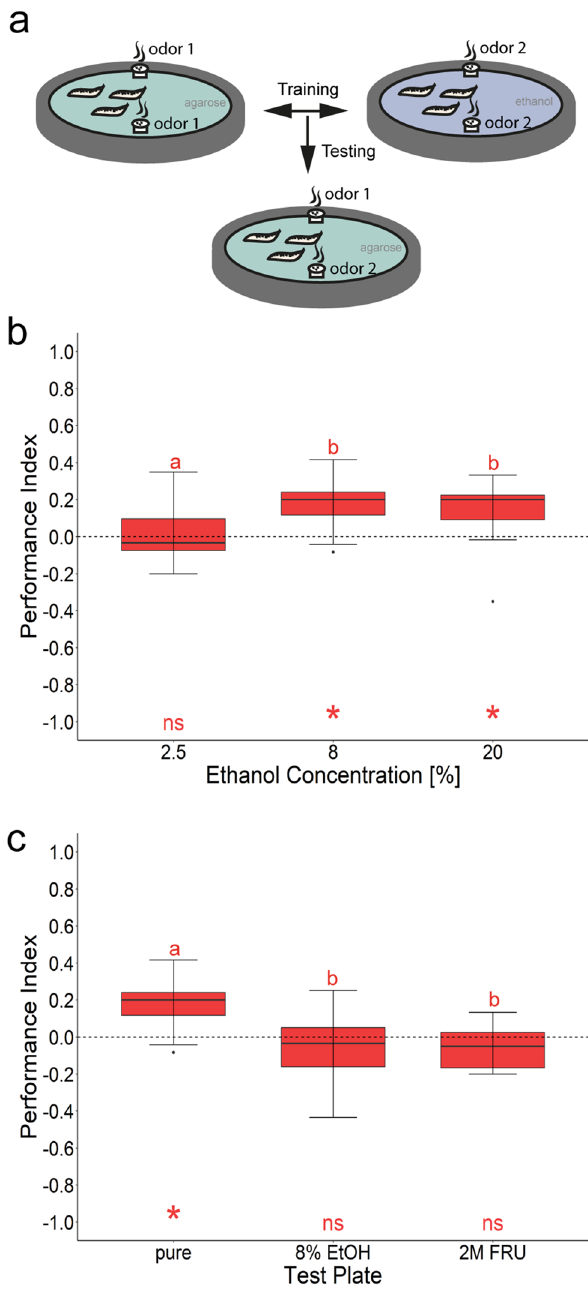
Figure 5. Larval olfactory learning reinforced by three different ethanol concentrations. ( a ) Scheme of the experimental procedure. Canton-S were trained three times with two odorants (AM and BA) and either 2.5%, 8%, or 20% ethanol as reinforcer. Olfactory memory is quantified by the performance index (PI). ( b ) Larvae trained with 8% and 20% ethanol concentration show a significant appetitive memory ( PI 8%Ethanol = 0.20, ci = 0.11–0.26, PI 20%Ethanol = 0.20, ci = 0.05–0.24, one-sample t test, p 8% < 0.001, p 20% < 0.005). When 2.5% ethanol was used as a teaching signal no memory was detectable ( PI 2.5%Ethanol = 0.83, ci = − 0.07 to 0.08, one-sample t test, p 2.5% < 0.828). Accordingly, larvae trained with 8% and 20% ethanol behaved differently from larvae trained with 2.5% ethanol (Dunn’s Multiple Comparison test, p < 0.001 and p < 0.003, respectively). ( c ) Larvae trained with 8% ethanol concentration as teaching signal and tested on control agarose showed a significant appetitive memory ( PI = 0.20 , ci = 0.11–0.26, one-sample t test, p < 0.001); if tested in the presence of the teaching signal of 8% ethanol or 2 M fructose (2 M FRU), appetitive associative memory is not expressed ( PI 8%Ethanol = − 0.03, ci = − 0.17 to 0.05, PI 2MFru = − 0.05, ci = − 0.11 to 0.01) as it is not significantly different from zero (one-sample t test, p 8%Ethanol < 0.260, p 2MFru < 0.080) and not significantly different from each other (paired t-test, p < 0.902). Differences against zero are indicated in red at the bottom of each panel. Sample size for each box plot is n = 15. Significant differences between the groups are indicated with letters; Preference scores and statistical tests underlying the different indices are documented in the Supplementary